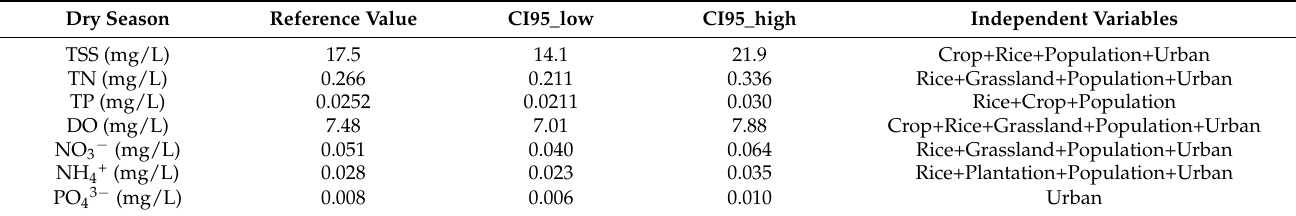
Table 3. Baseline reference values for the dry and wet season, calculated with anthropogenic models (also reported). CI95_low and CI95_high refer to the lower and higher 95% confidence interval,